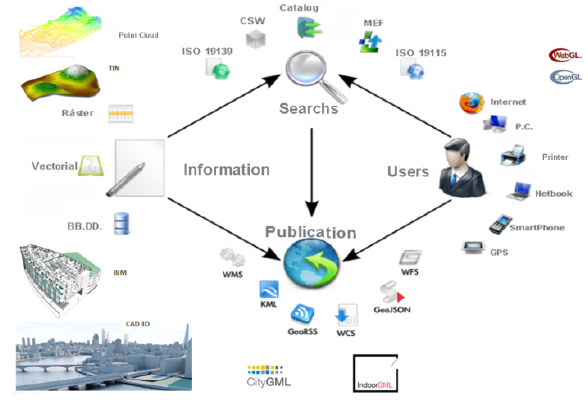
Figure 8. Publishing of 3D models with interoperability.